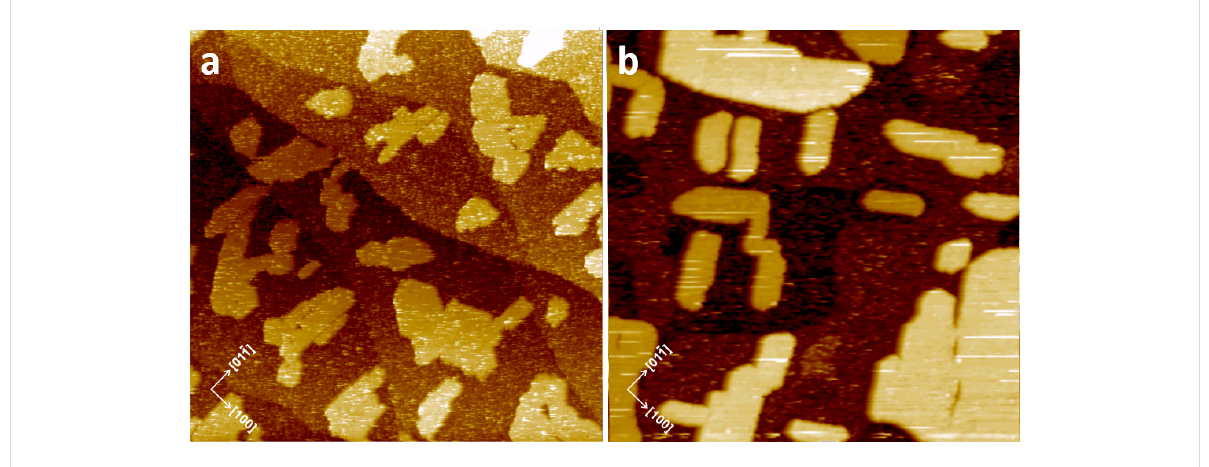
Figure 5: 250 × 250 nm empty state STM images of ZnPc (a) and CuPc (b) structures formed on top of the ZnTPP wetting layer covering the TiO